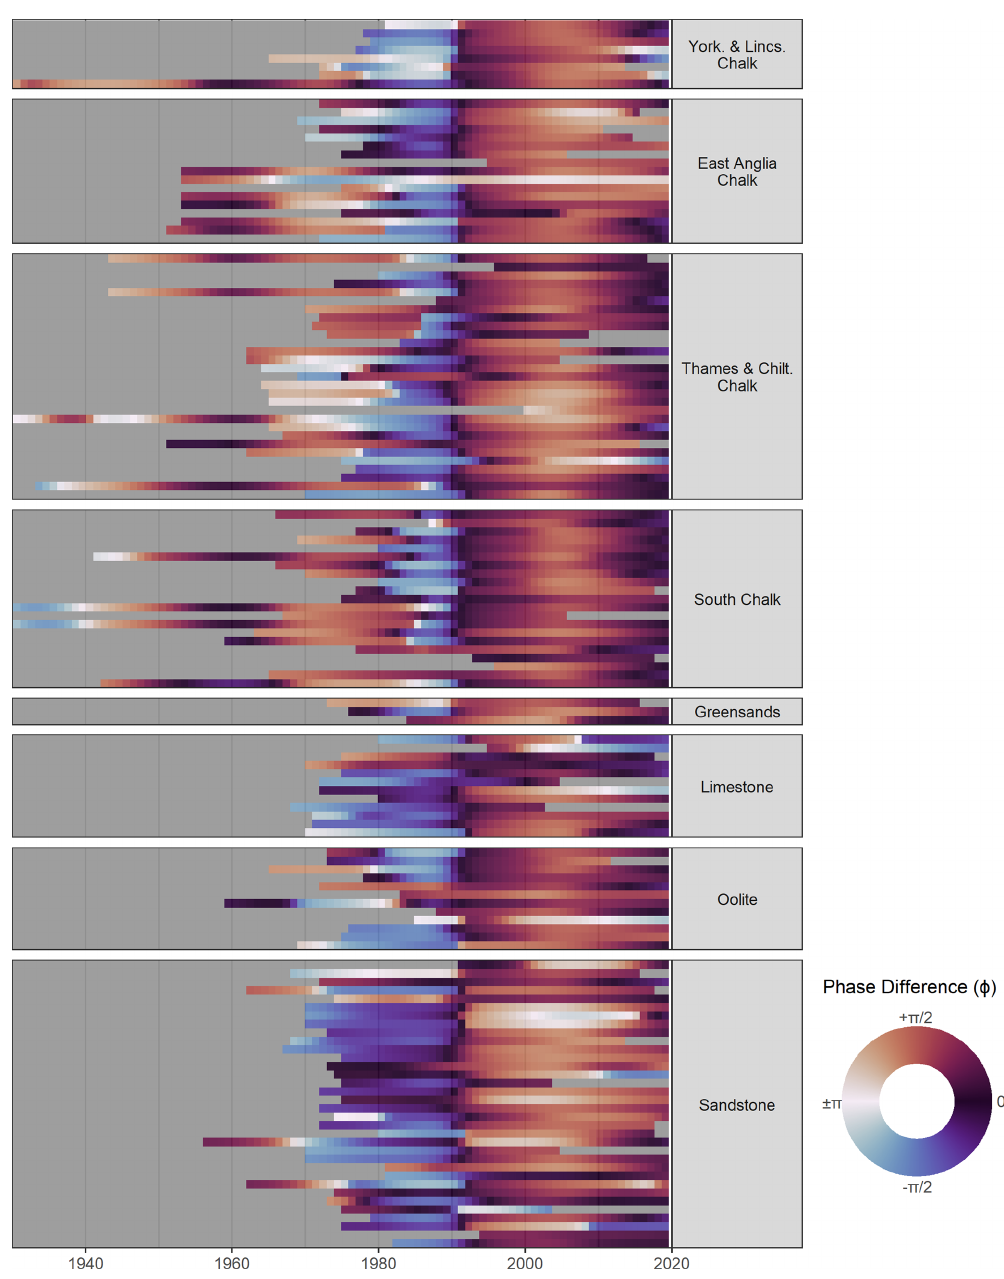
Figure 4. Phase difference between the NAOI and each GWL record for the GWL record period. Results are grouped by aquifer regions. φ = 0 is equivalent to an in-phase relationship and φ = ± π is equivalent to an anti-phase relationship.